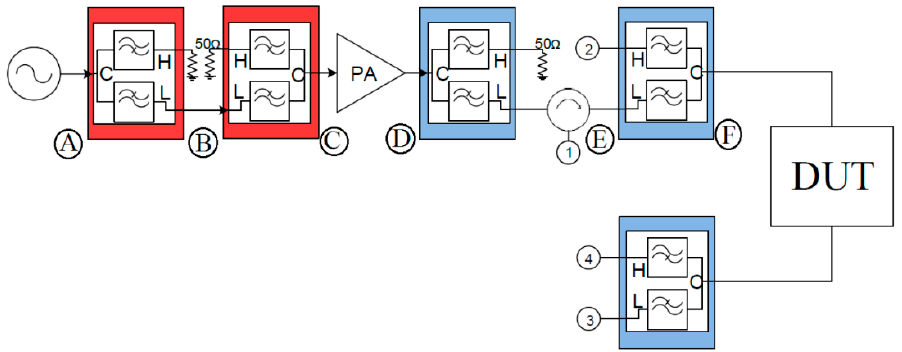
Figure 8. Block diagram of the linear/nonlinear measurement system with specific test locations marked.